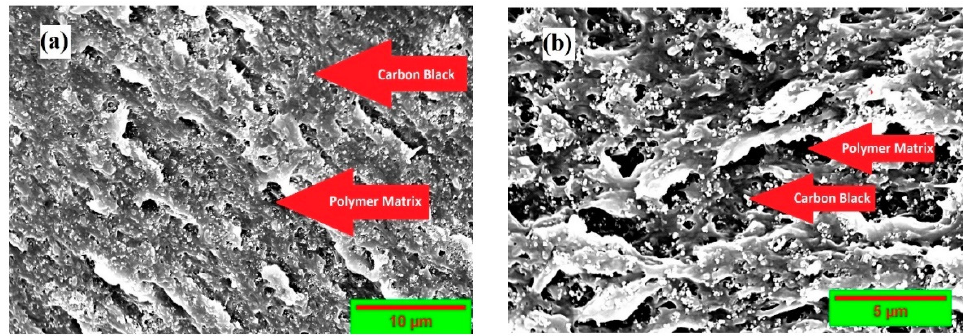
Figure 1. Scanning microscope micrograph of styrene-b-(ethylene-co-butylenes)-b-styrene triblock copolymer. ( a ) Surface morphology with CB nanocomposite; ( b ) cross-section of prepared nanocomposite.